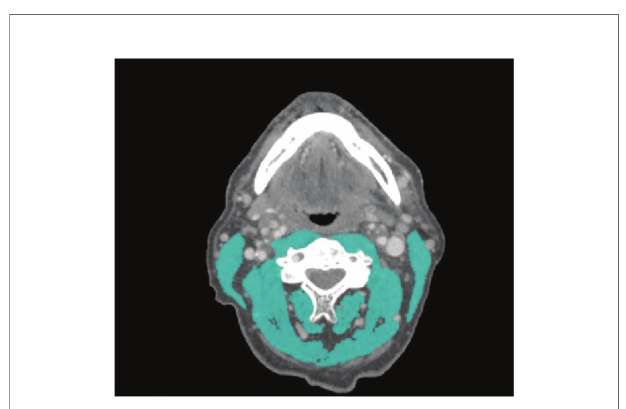
FIGURE 2 | Delineation of skeletal muscle tissue on transversal CT imaging at the level of C3. A Houns fi eld Unit window of -29 to +150 was used to accentuate skeletal